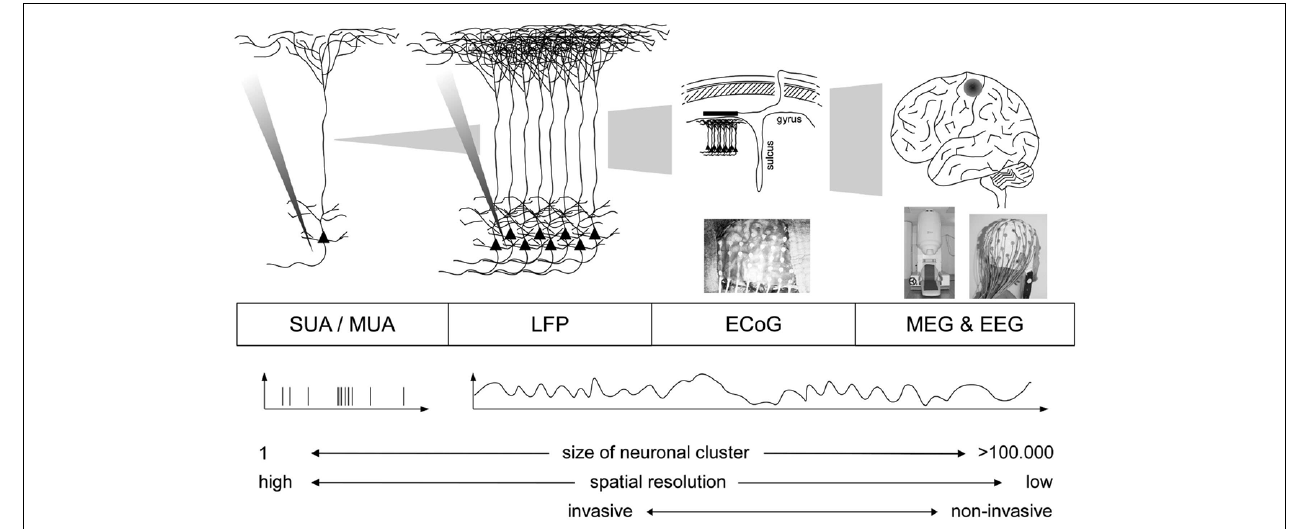
FIGURE 21 | (Data Set 3). Schematic overview of different recording techniques for BMIs (fromWaldert et al., 2009 with permission).